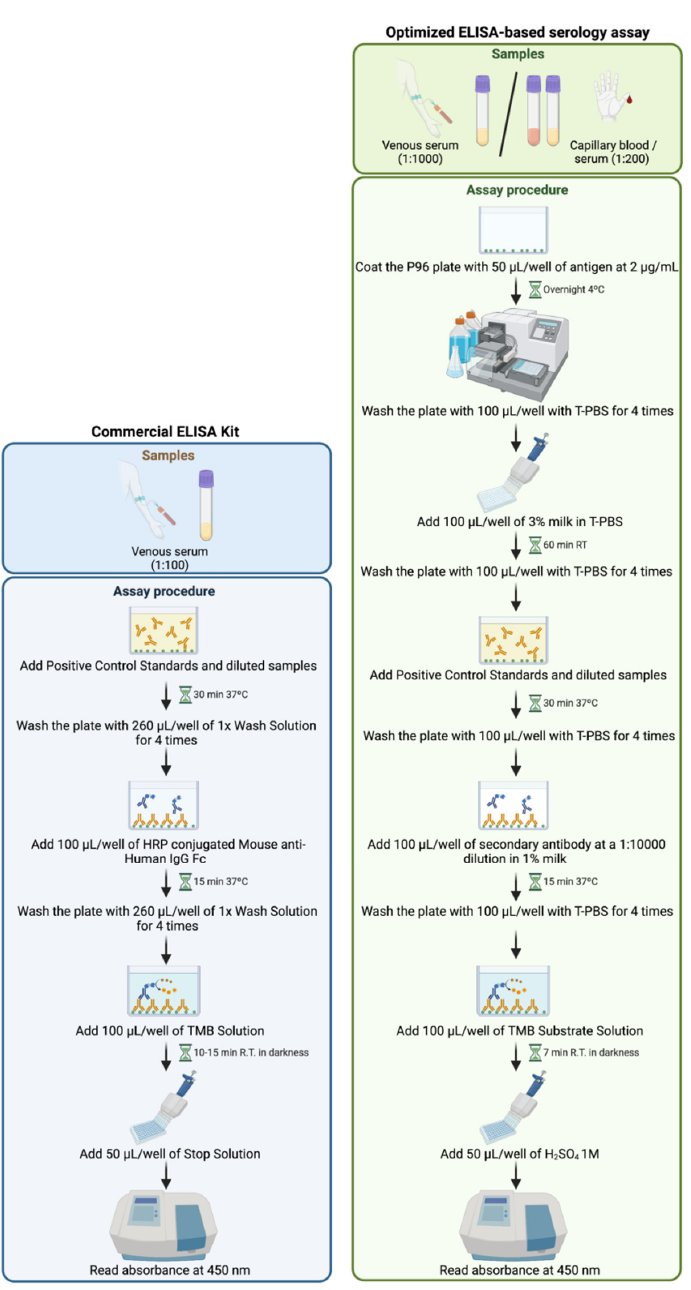
Figure 1. Schematic representation of ELISA protocol, comparing both methods. On the left, commercially available ELISA Detection Kit (GenScript USA Inc.). On the right, protocol for the optimized ELISA-based serology assay described in this paper.